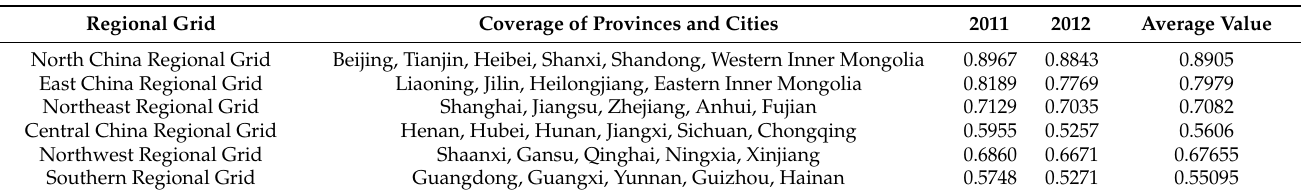
Table 4. Electricity carbon emission